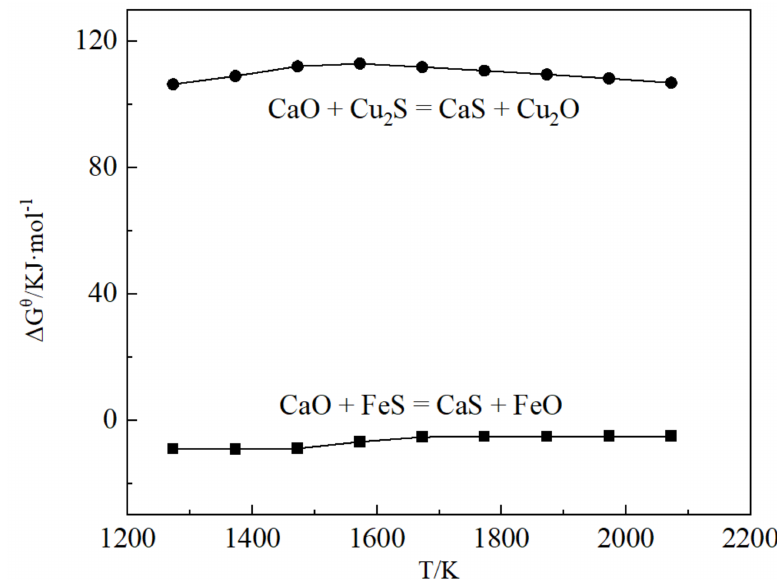
Figure 3. The Gibbs free energy of CaO desulfurization